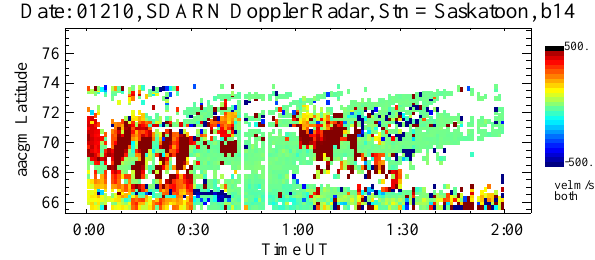
Fig. 6. Velocity in the ionospheric F -region along beam 14 of the SuperDARN Saskatoon radar between 00:00UT and 02:00UT on 10 December 2000. Positive velocities are in the direction toward the radar (close to the south-west direction above Fort Churchill).